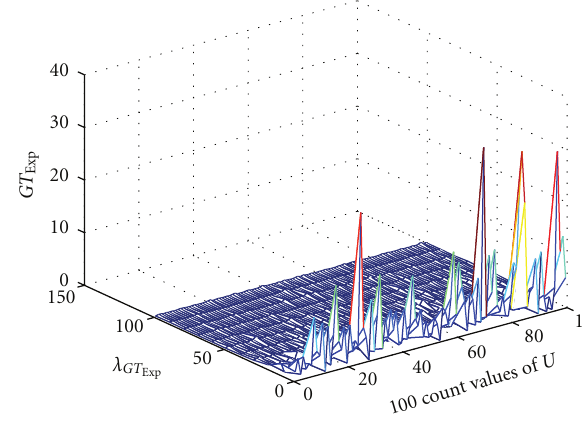
Figure 3: GT Exp versus λ GT